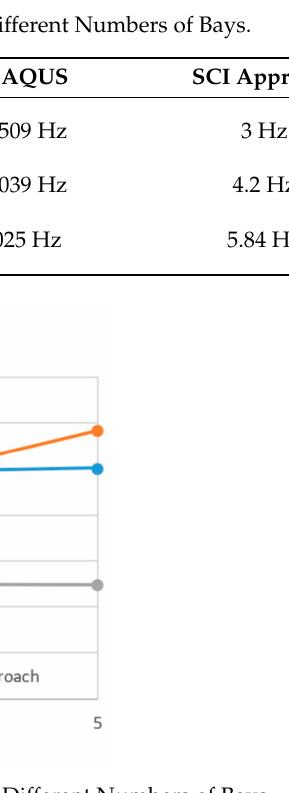
Figure 13. Comparison of Fundamental Frequency between Different Numbers of Bays.